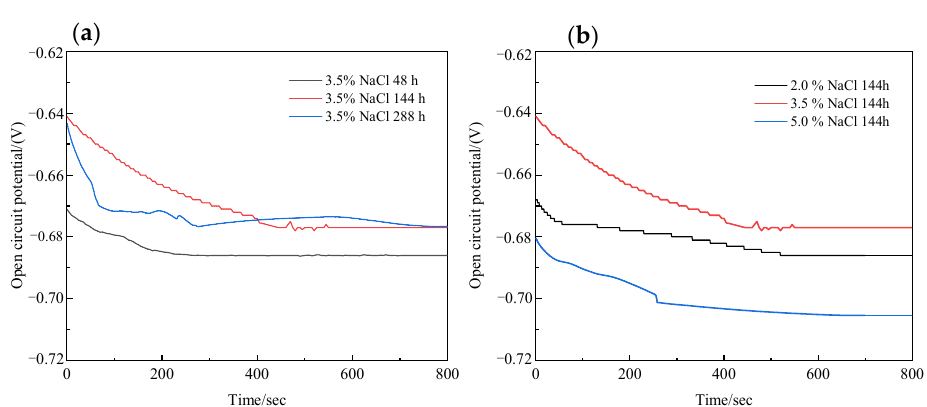
Figure 8. Open circuit potential of ER8 wheel steel under different conditions: ( a ) different immersion times and ( b ) different concentrations.